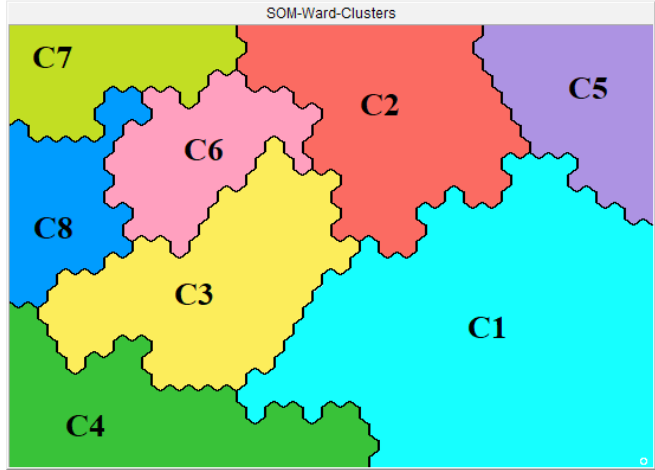
Figure 3. New Kohonen map with conditional financial intermediaries